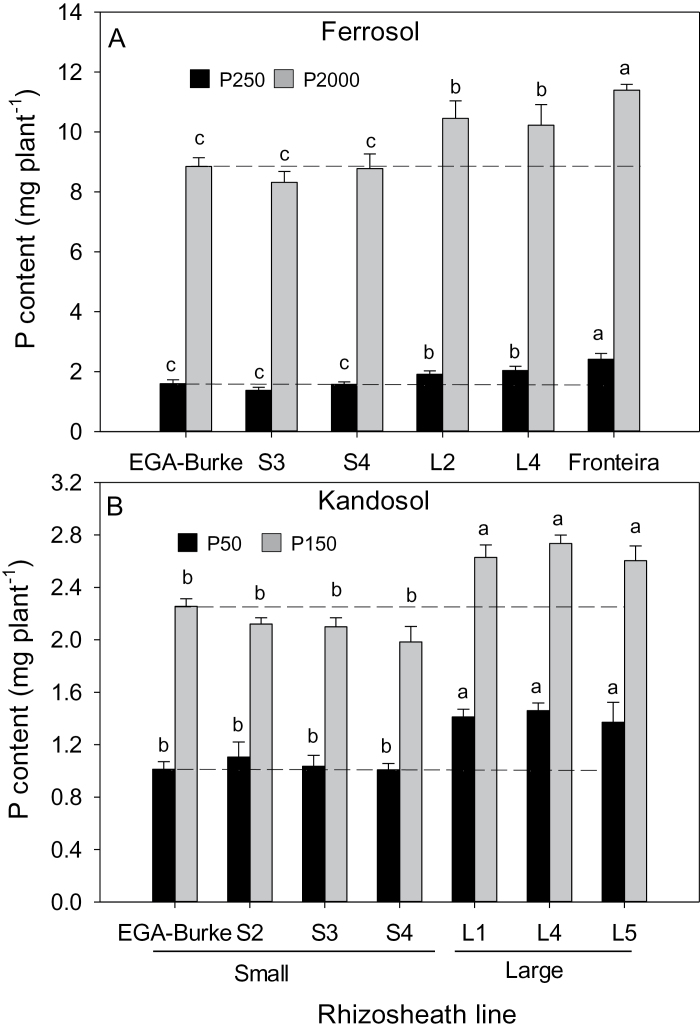
Shoot P content (total P accumulated) in shoots of EGA Burke and BC3 NILS with large (L) or small rhizosheaths (S) grown in (A) acid ferrosol (pH 4.3) with 125mg kg−1 or 2000mg kg−1 added P or (B) acid kandosol (pH 4.0) with 50mg kg−1 or 150mg kg−1 added P. Values are means (n=4) and different letters indicate significant differences (P<0.05) between genotype means (no interaction between genotypes and treatments). For reference, the dashed lines show shoot P content of EGA Burke at low (lower lines) and high (upper lines) P treatments.